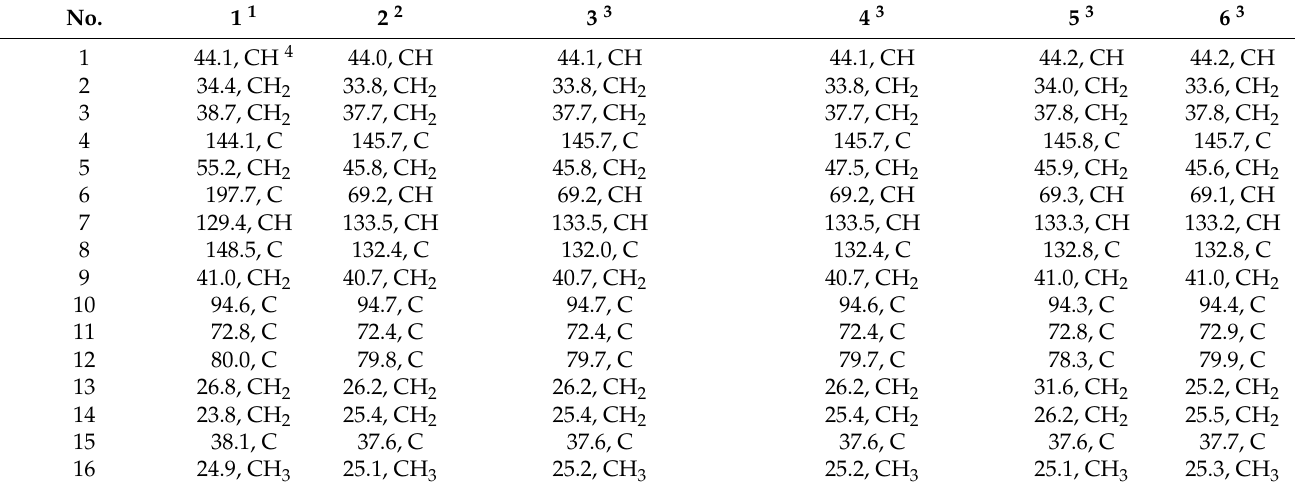
Table 1. 13 C NMR spectroscopic data of compounds 1 – 6